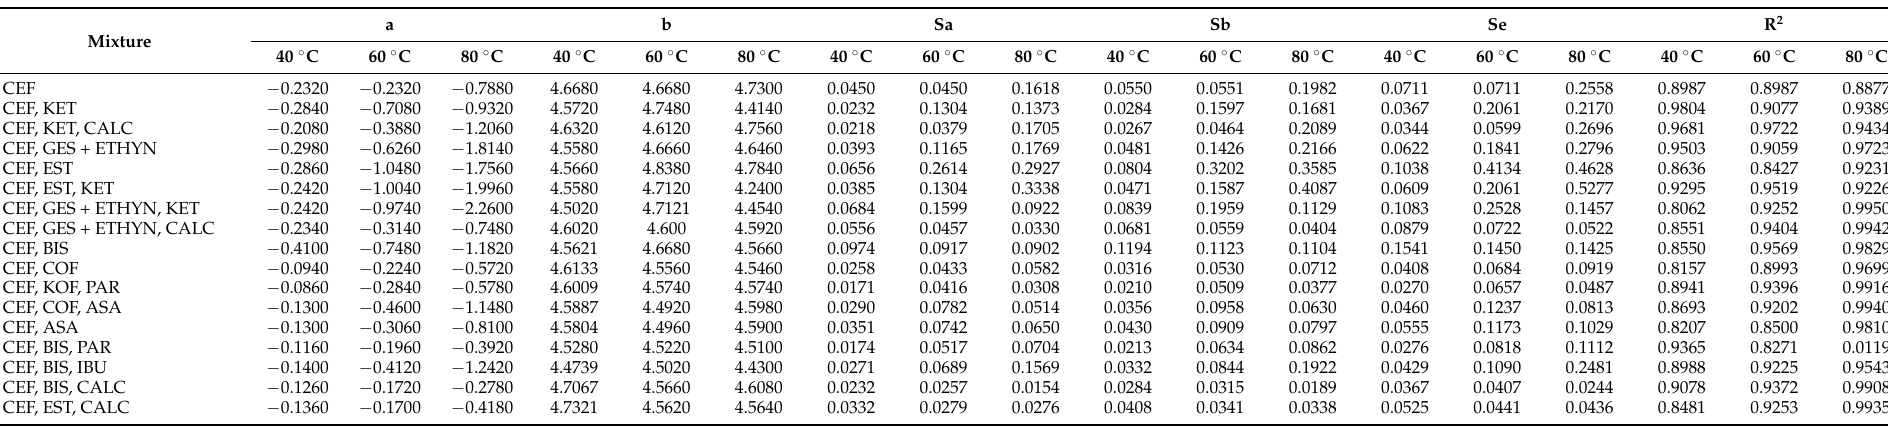
Table 5. Statistical parameters of calibration curves of cefepime in the tested drug mixtures at 40, 60 and 80 ◦